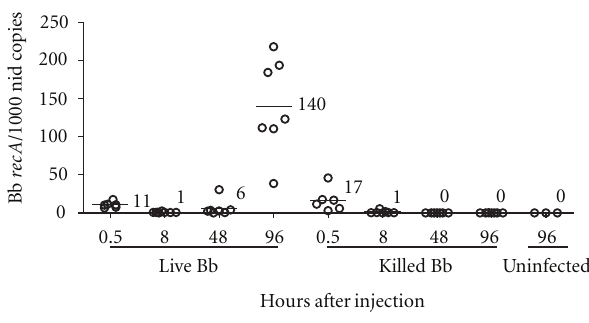
Figure 3: DNA from killed Bb is rapidly cleared from infection sites and is undetectable by PCR. Groups of mice were injected intradermally with 10 4 of either live or heat-killed Bb. Mice were sacrificed at the indicated times after injection, and a 6 mm skin sample encompassing the injection site was excised for DNA preparation. The relative Bb levels were assessed by real-time PCR using recA primers and normalized relative to the murine nid content. Each circle represents Bb recA levels relative to 1000 nid copies for an individual animal, and the number beside the bar indicates the average value for that group. These data reflect the combined results of two separate